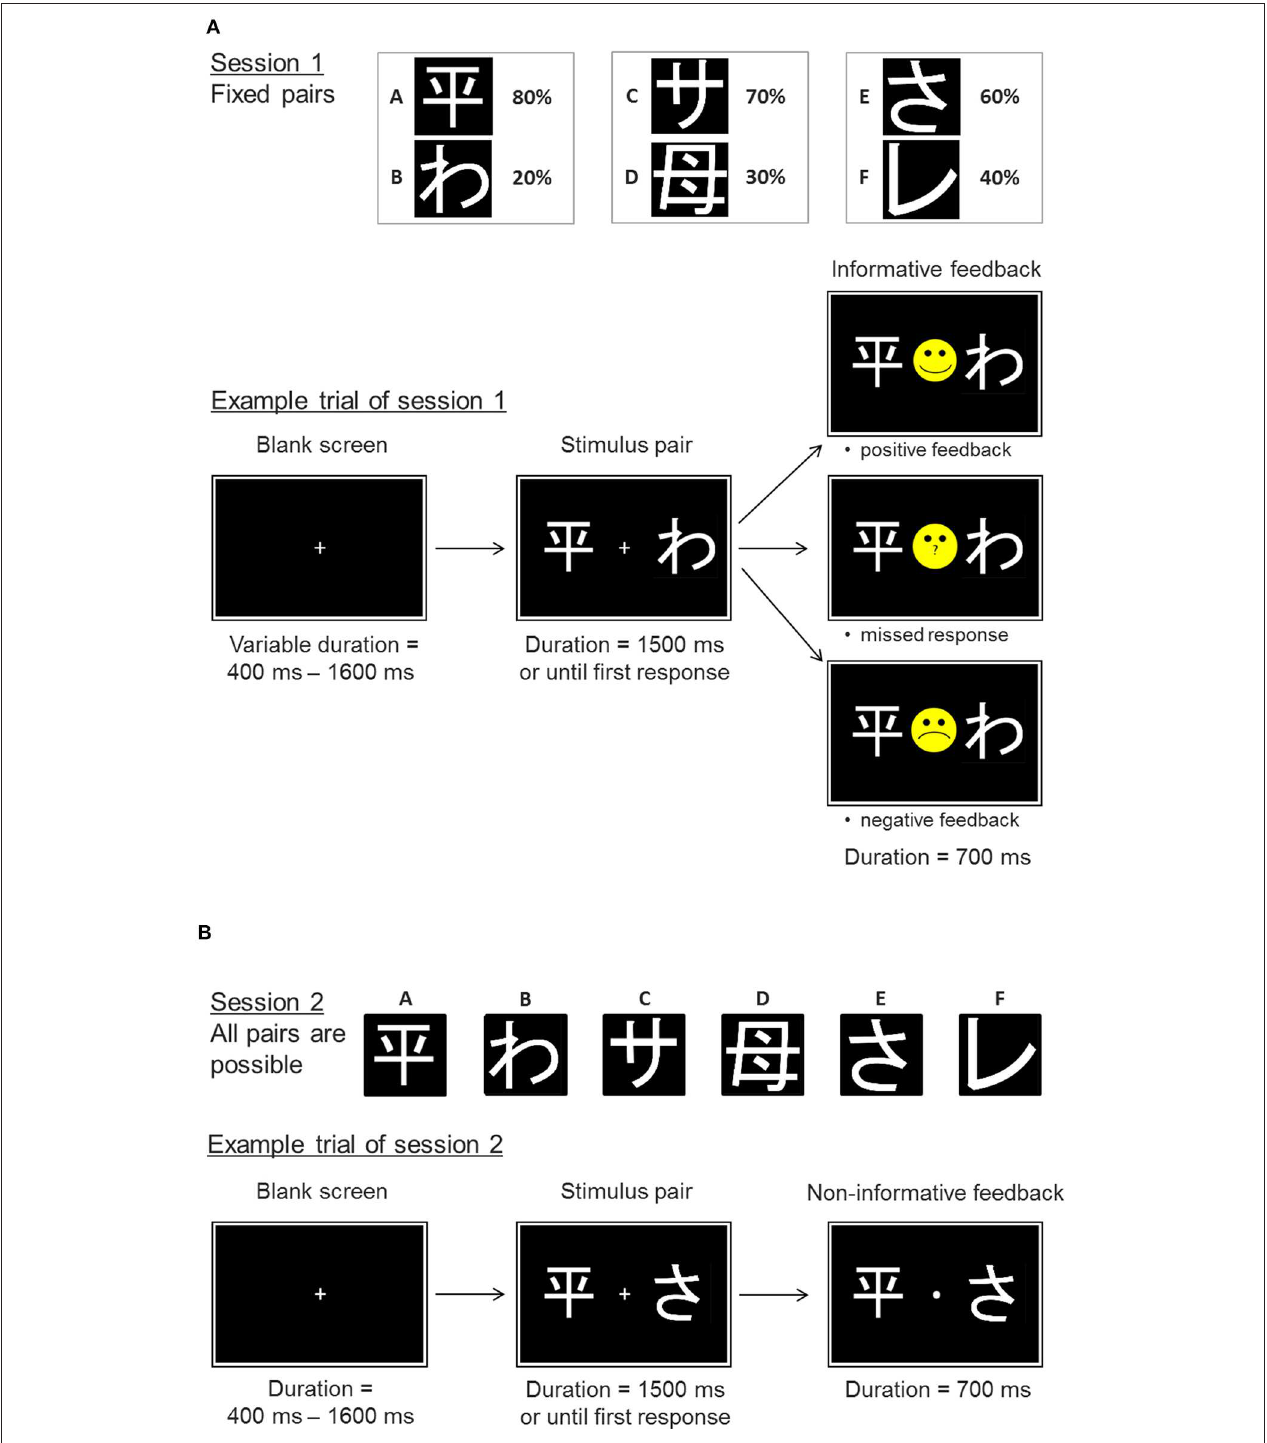
FIGURE 1 | Experimental paradigm. Example trials of the probabilistic feedback task. (A) Session 1 represents the learning phase with the fixed stimulus pairs AB, CD, and EF. The probabilities of positive feedback are displayed next to the respective symbols. Example trial: a trial starts with a blank screen delay of variable length. Then the stimulus pair is shown until a response is made or until 1,500ms have passed without responding. Following the response or the 1,500ms the participant receives an informative feedback, which either indicates a positive or negative performance outcome (smiley vs. grumpy face) or informs the participant that no response has been made. (B) In the transfer phase (session 2) the participants are not only confronted with the original pairs, but also face novel pairs. Responses are no longer followed by informative feedback, but participants just receive a dot indicating that a response has been made.